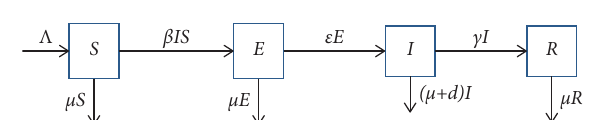
Figure 1: Transmission diagram for